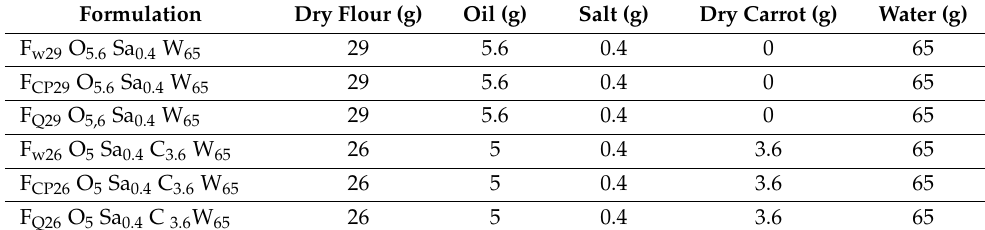
Table 1. Formulations of the different sponge cake batters with and without carrots. Formulation Dry Flour (g) Oil (g)